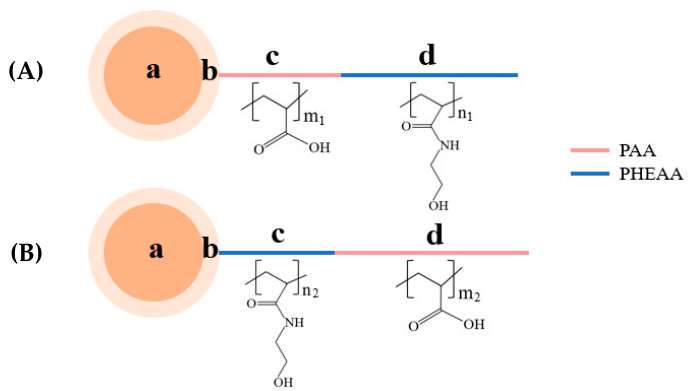
Figure A1. Schematic diagram of chain length according to calculated molar ratio from the elemental analysis data and molecular structure for ( A ) PSV@PAA-b-PHEAA and ( B ) PSV@PHEAA-b-PAA (a, b, c and d represent the size / length of the PS seed, photoiniferter 4-vinylbenzyl N, N-diethyldithiocarbamate (VBDC), inner block and outer block, respectively).